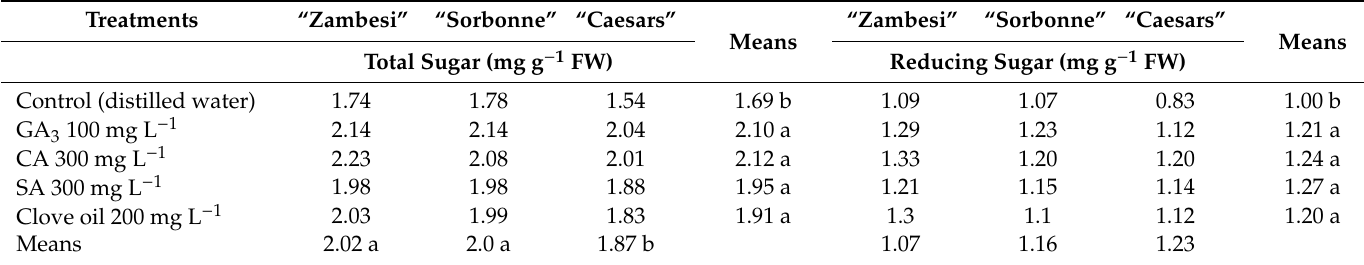
Table 5. Comparative analysis of the e ff ects of di ff erent vase solutions on the total sugar, reducing sugar, nonreducing sugar, and total phenol of three cultivars of cut lily